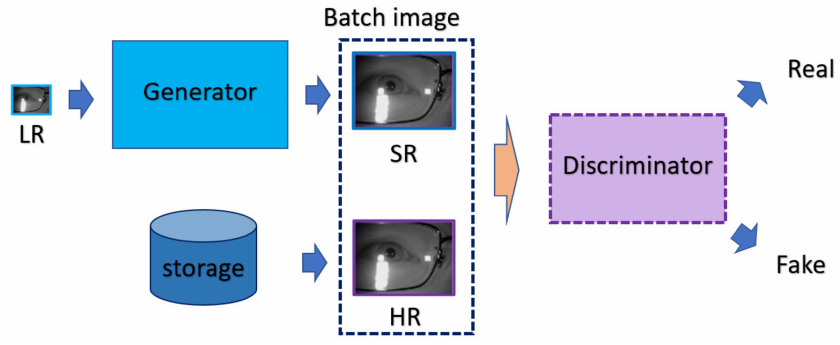
Figure 5. The training process of